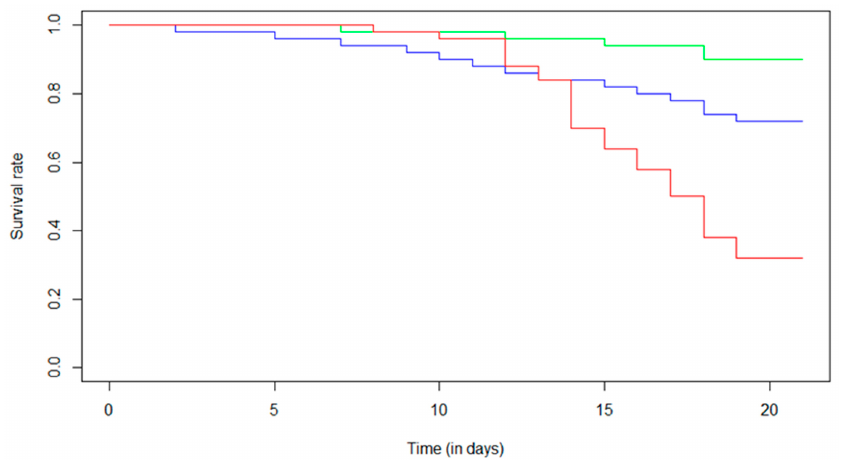
Figure 1. Effect of chronic exposure at different fipronil concentrations on the survival of A. mellifera. The Kaplan–Meier distribution shows the survival proportions of bees (i) not exposed to fipronil (control, green line), (ii) exposed to 0.5 µg/L of fipronil (Fip 0.5, blue line), and (iii) exposed to 1 µg/L of fipronil (Fip 1, red line). The Cox–Mantel test shows a significant decrease in survival of bees exposed to both fipronil concentrations compared with control group ( p -value = 0.020 for Fip 0.5 and p -value ≤ 0.0001 for Fip 1). In addition, a significant difference was observed between the two exposed groups ( p -value = 0.0003).